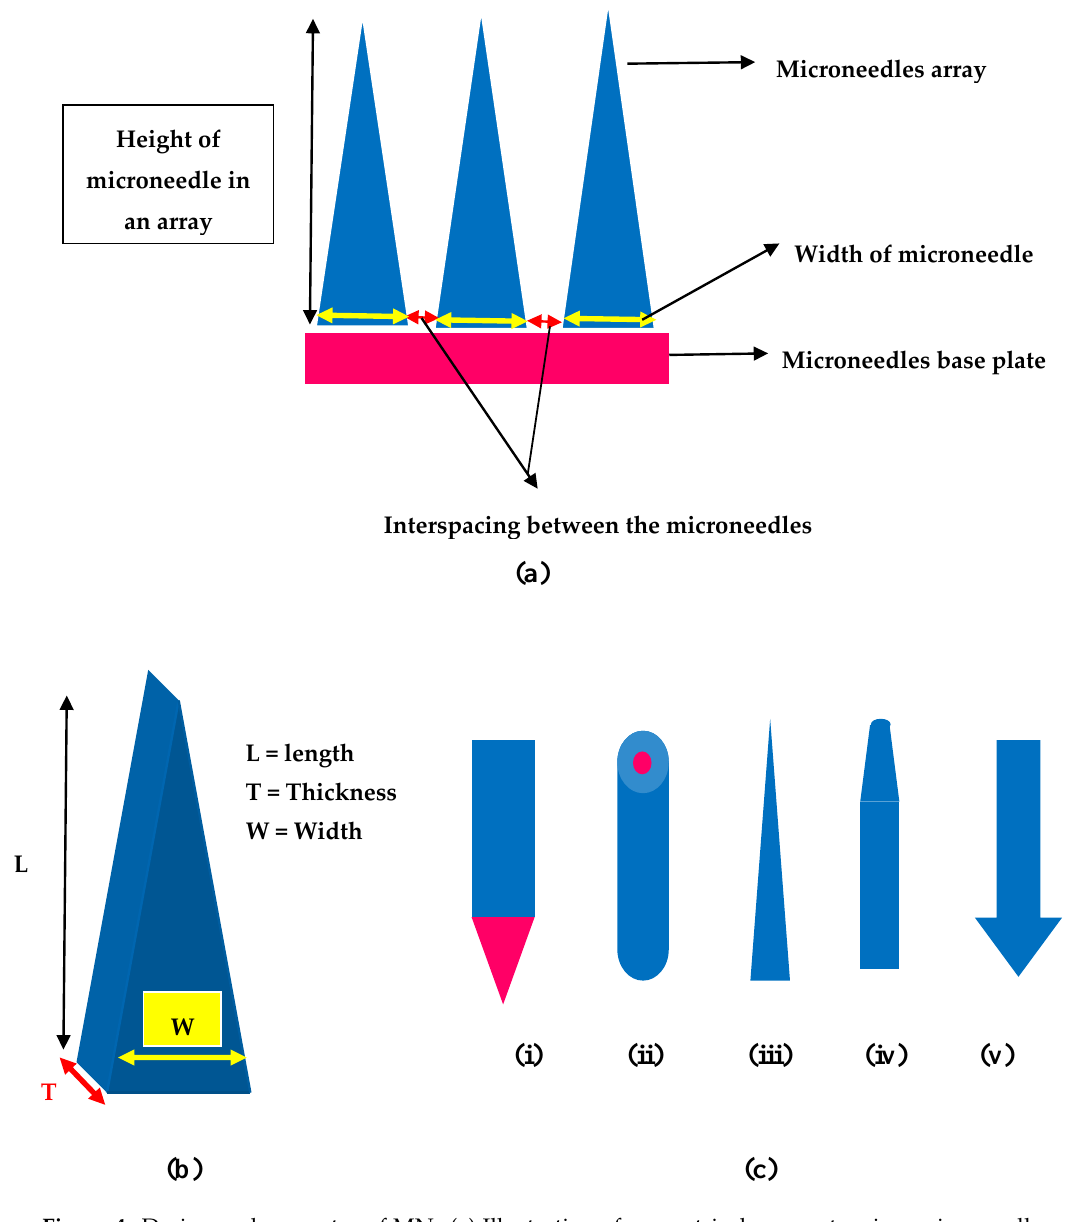
Figure 4. Design and geometry of MNs ( a ) Illustration of geometrical parameters in a microneedle array ( b ) Geometry of MNs length (L), thickness (T) and width (W) ( c ) Different shapes of MNs ( i ) Rectangular microneedle with sharp edge ( ii ) cylindrical ( iii ) conical ( iv ) tapered ( v ) arrow headed.